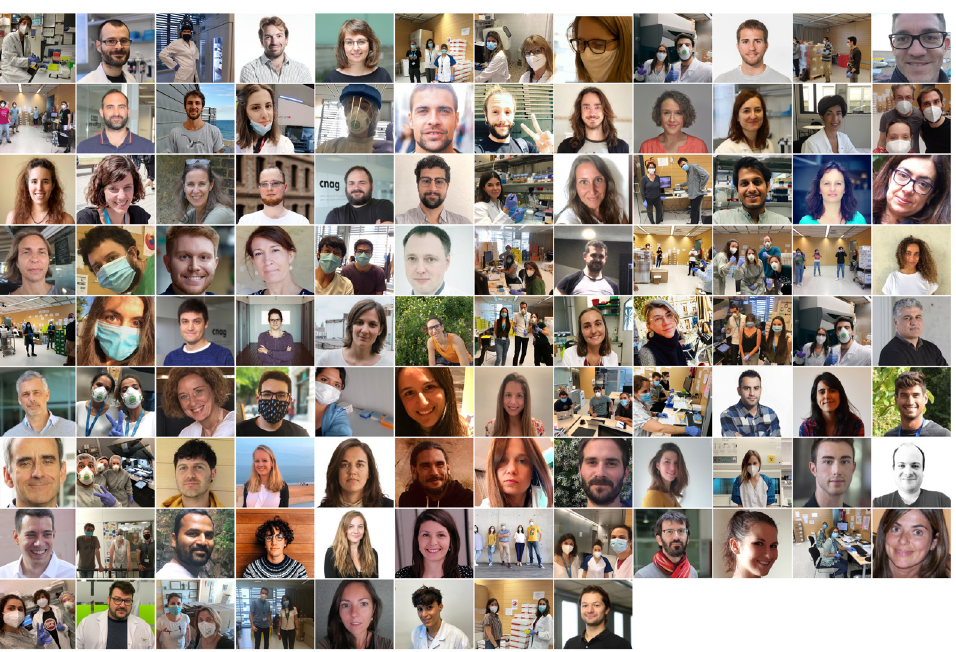
Figure 2. Some of the volunteers across the Barcelona Biomedical Research Park and Barcelona Science Park nodes who took part in the ORFEU project. We confirm that we have obtained written informed consent to use images of the individuals included in this